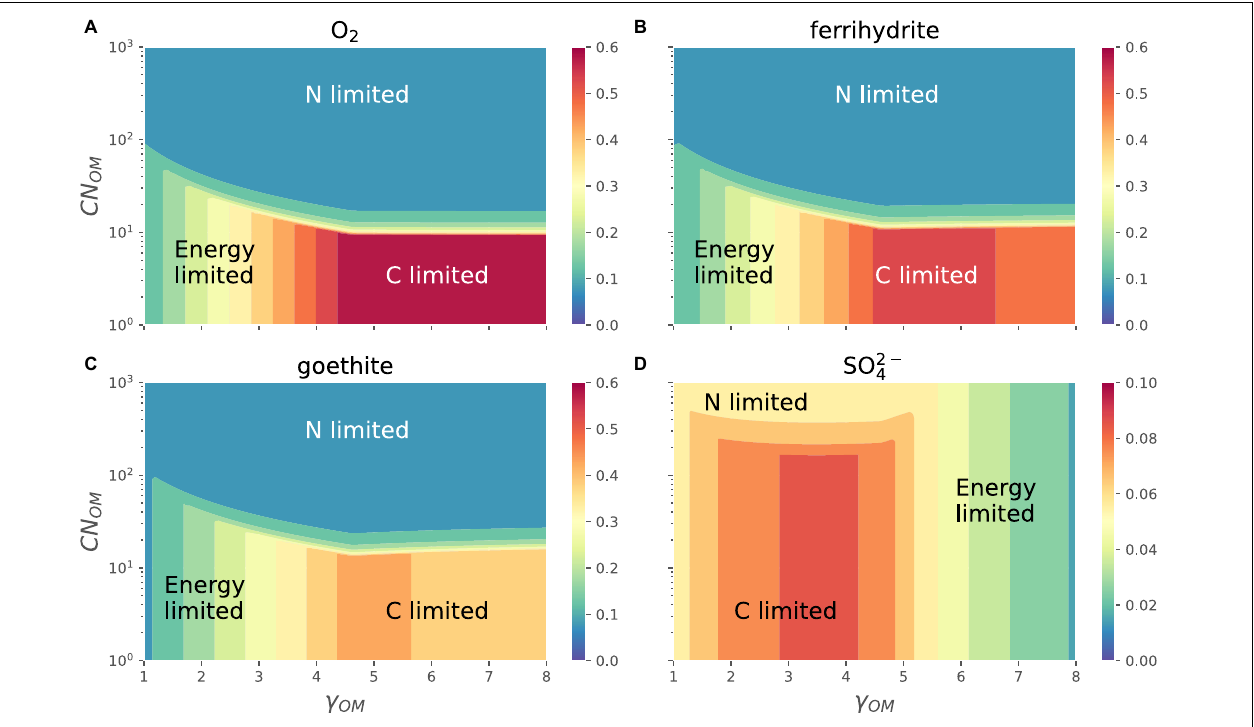
FIGURE 7 | OM containing N: variation of normalized microbial growth rate ( G norm ; contours with different colors) along a gradient of OM C:N ratio [ CN OM in C-mol (N-mol) − 1 ] and OM degree of reduction ( γ OM ) for different EAs [panels (A–D) ]. A constant value of I norm = 0.01 was assumed in all panels. Note that the color scale in the bottom right panel is different from those in the other three panels (A–C)